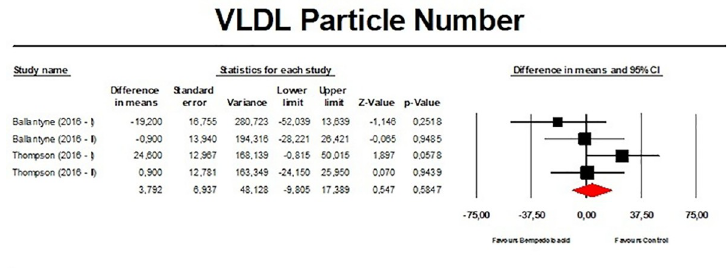
Fig 11. Forest plot displaying mean difference and 95% confidence intervals for the effect of bempedoic acid on plasma levels of very-low-density lipoprotein (VLDL) particle number.